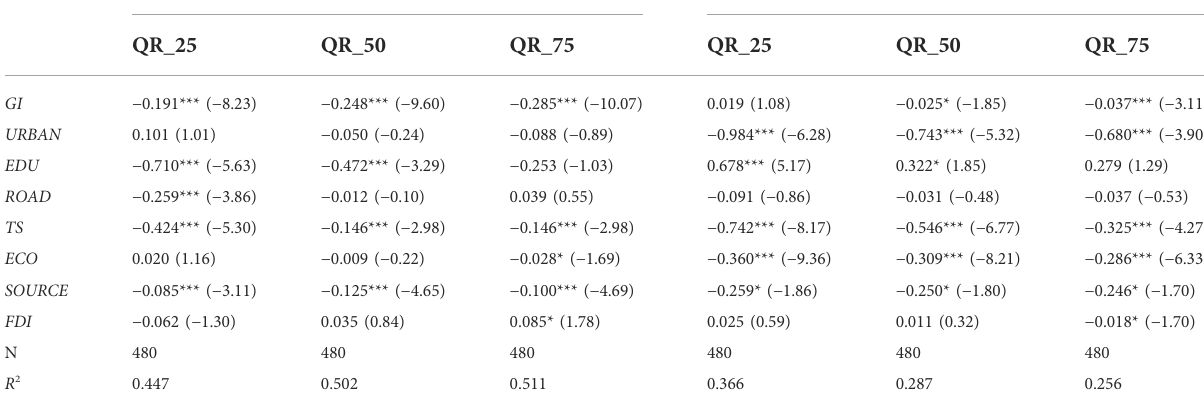
TABLE 6 Quantile regression results.